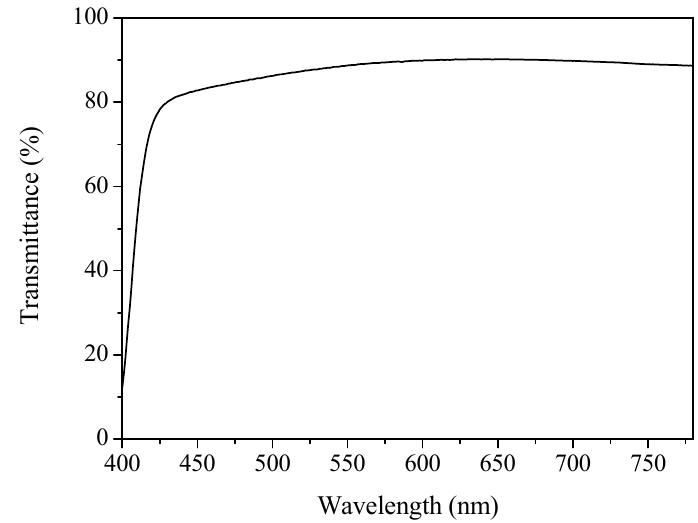
Figure 11. The measured optical transmittance of the fabricated absorber.